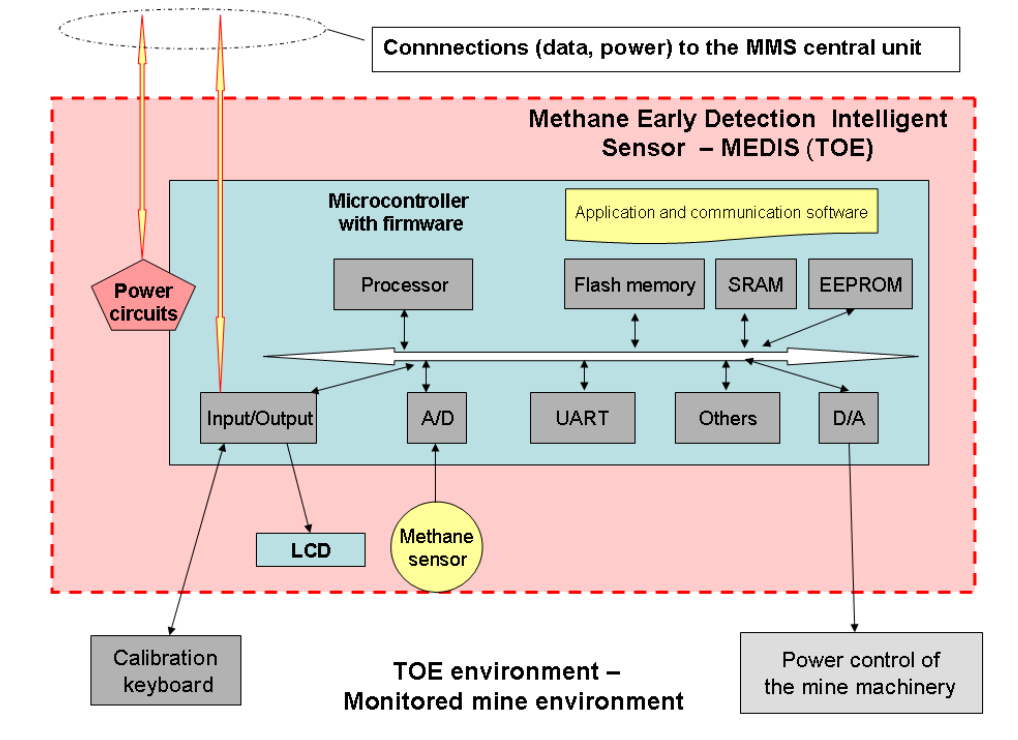
Figure 3. MEDIS—Methane Early Detection Intelligent Sensor as the